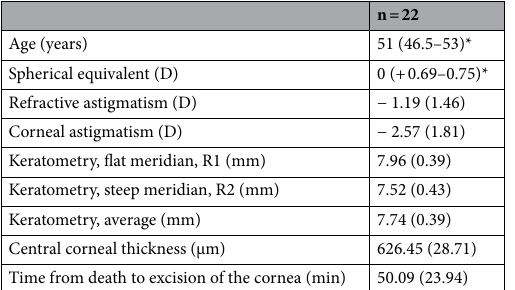
Table 1. Baseline characteristics of enrolled eyes (pre-excision values); mean values (± SD). *Median (Q1–